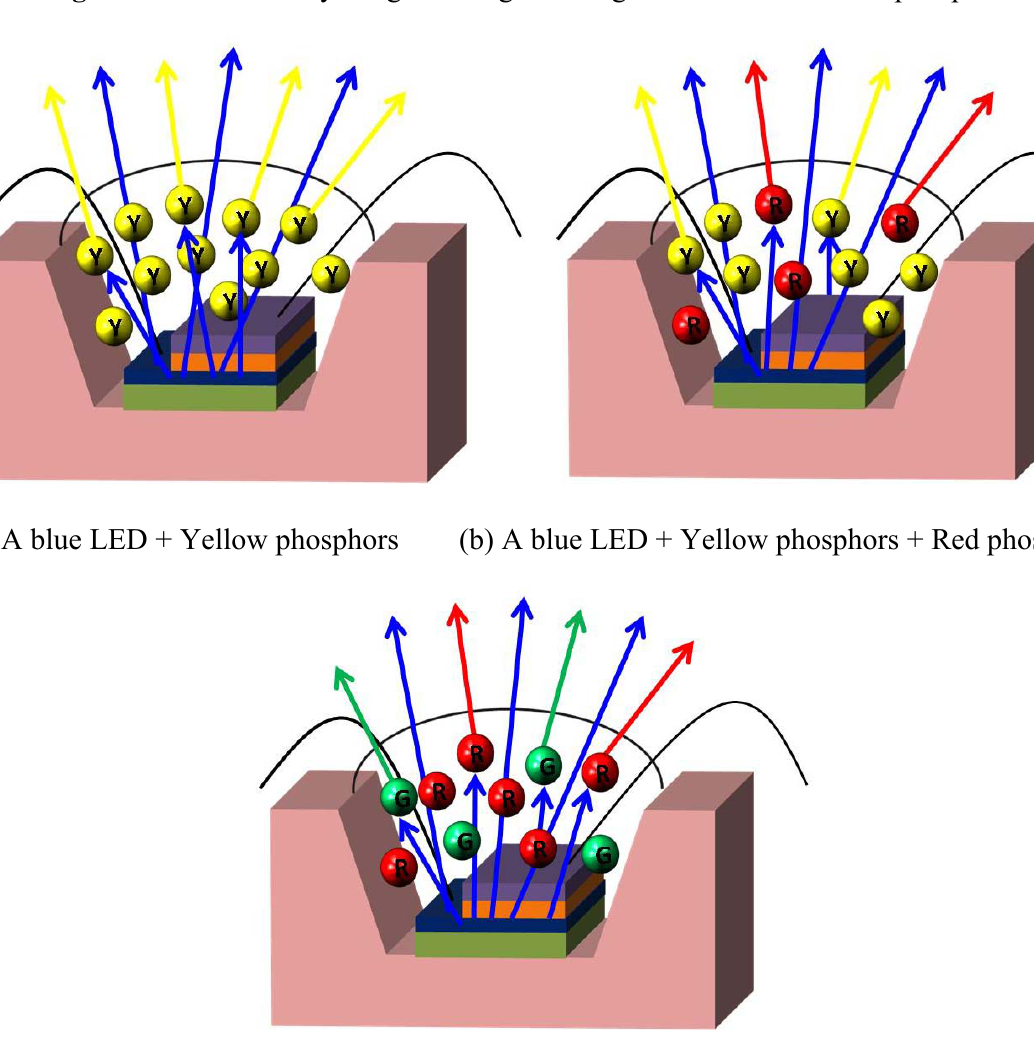
Figure 1. Different ways of generating white light with blue LED and